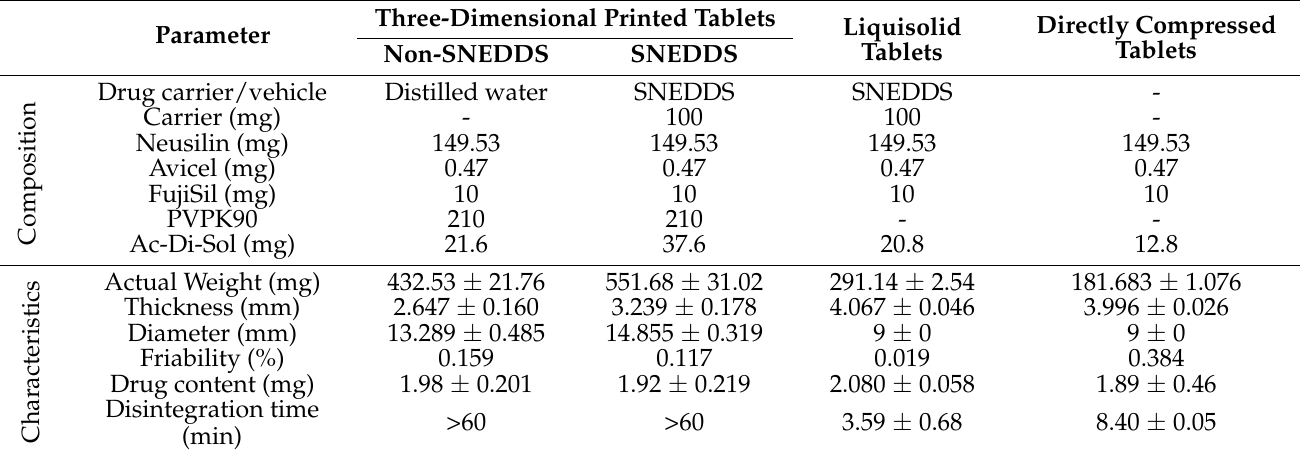
Table 1. Composition and quality control tests of the prepared glimepiride